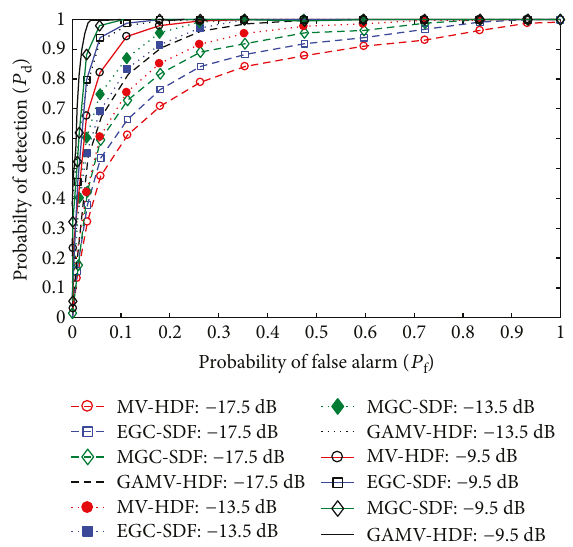
Figure 4: Probability of detection versus probability of false alarm (ROC) at di ff erent SNR values with MUs having low SNR compared with